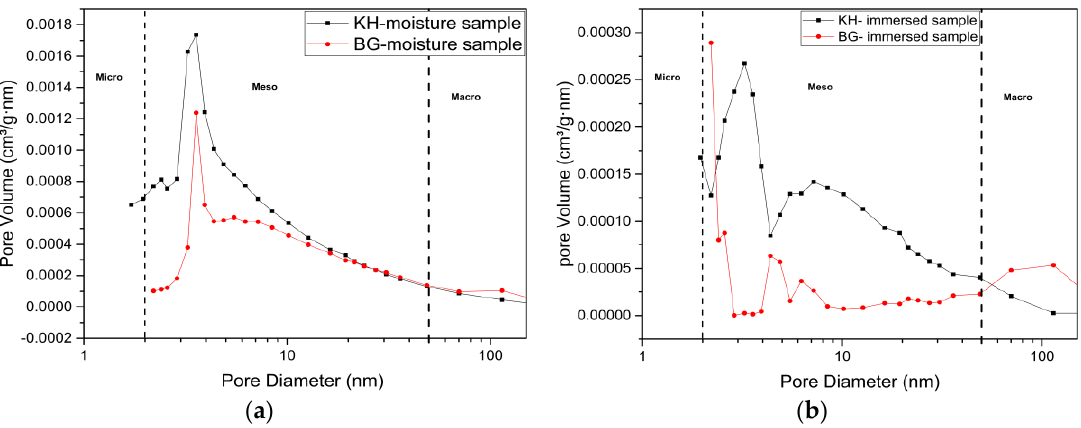
Figure 6. Pore size distribution defined by differential pore volume by low pressure gas N2 adsorption analysis. ( a ) Moisture case; ( b ) Immersed water case.